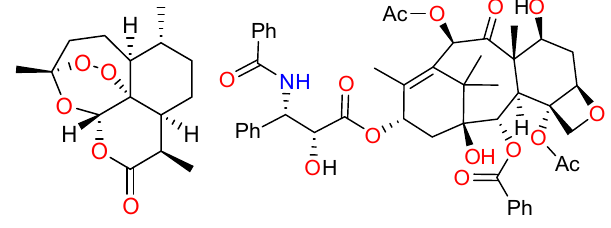
Figure 1. Structures of artemisinin and Taxol ® .